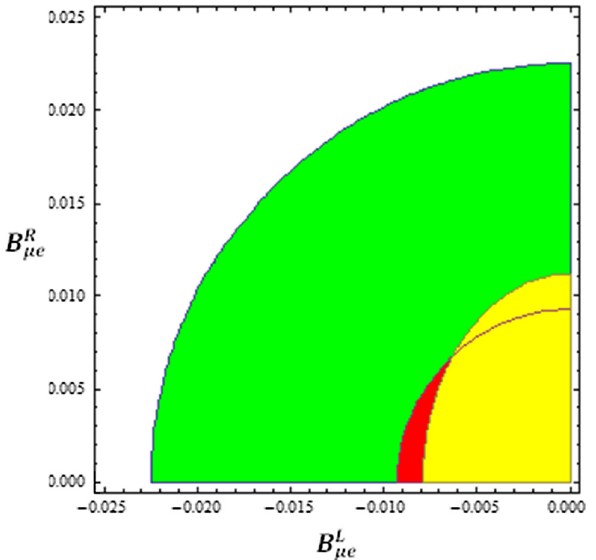
Fig. 1 The parameter space allowed by the experimental upper limits mentioned at Eq. (21)